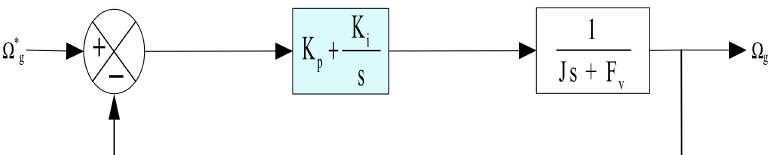
Figure 7. Typical regulator PI